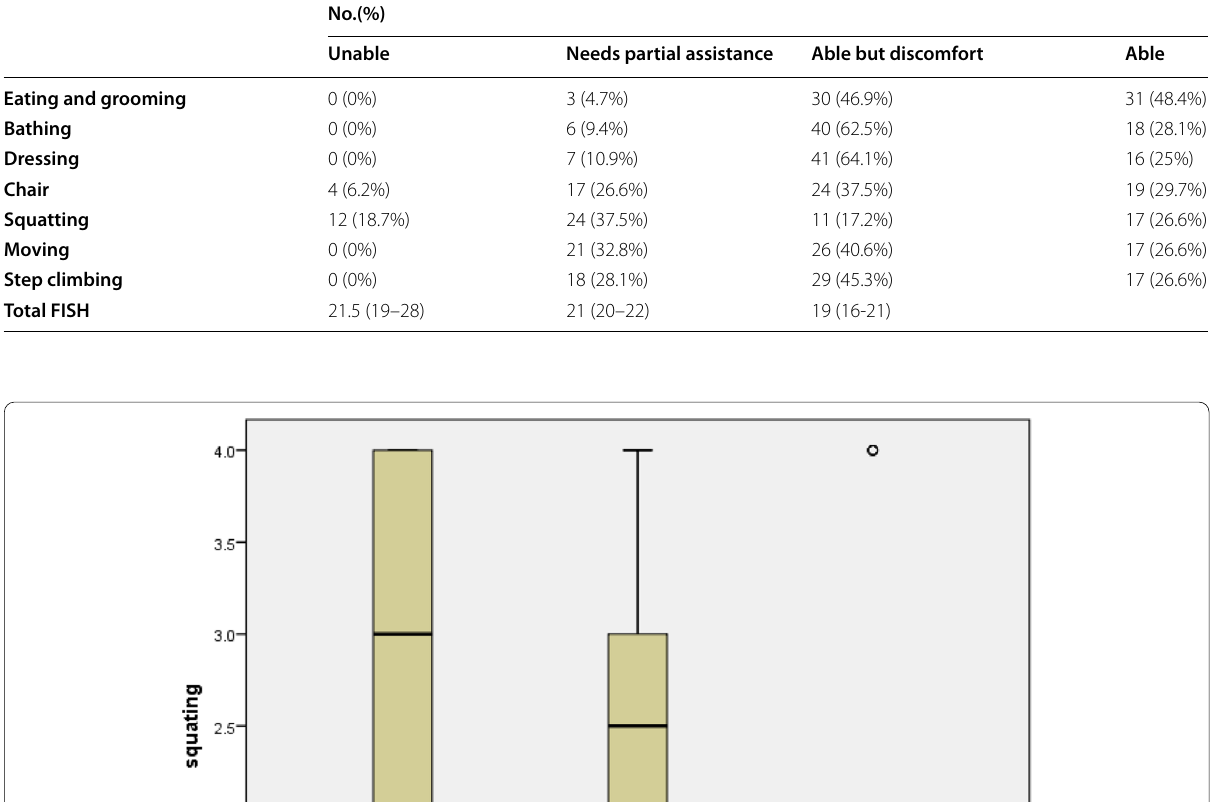
Table 1 The functional independence score in hemophilia (FISH)